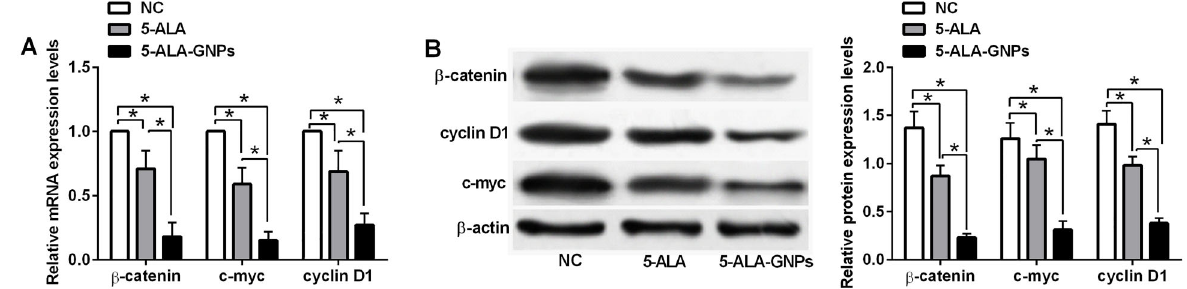
Figure 6. Effects of in vitro photodynamic therapy (PDT) on Wnt/ b -catenin signaling activities in A431 cells. A , mRNA expression and ( B ) protein expression of b -catenin, c-myc, and cyclin D1 in A431 cells after in vitro PDT with 5-aminolevulinic acid (5-ALA) (4 mM), 5- ALA-gold nanoparticles (GNPs) (8 mM), or phosphate-buffered saline PBS (NC) was determined by qRT-PCR assay and western blot assay. Data are reported as means ± SD (n=3). Signi fi cant differences between groups are indicated as *P o 0.05 (one-way ANOVA).